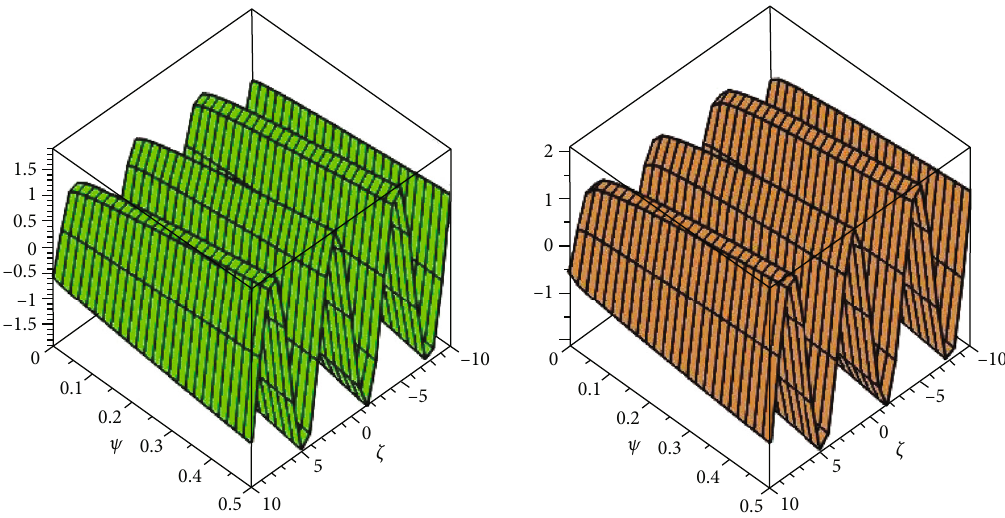
Figure 4: The YDM solution of example 1 of μ ð ζ , Ψ Þ at δ = 0 : 6 , and 0 : 4